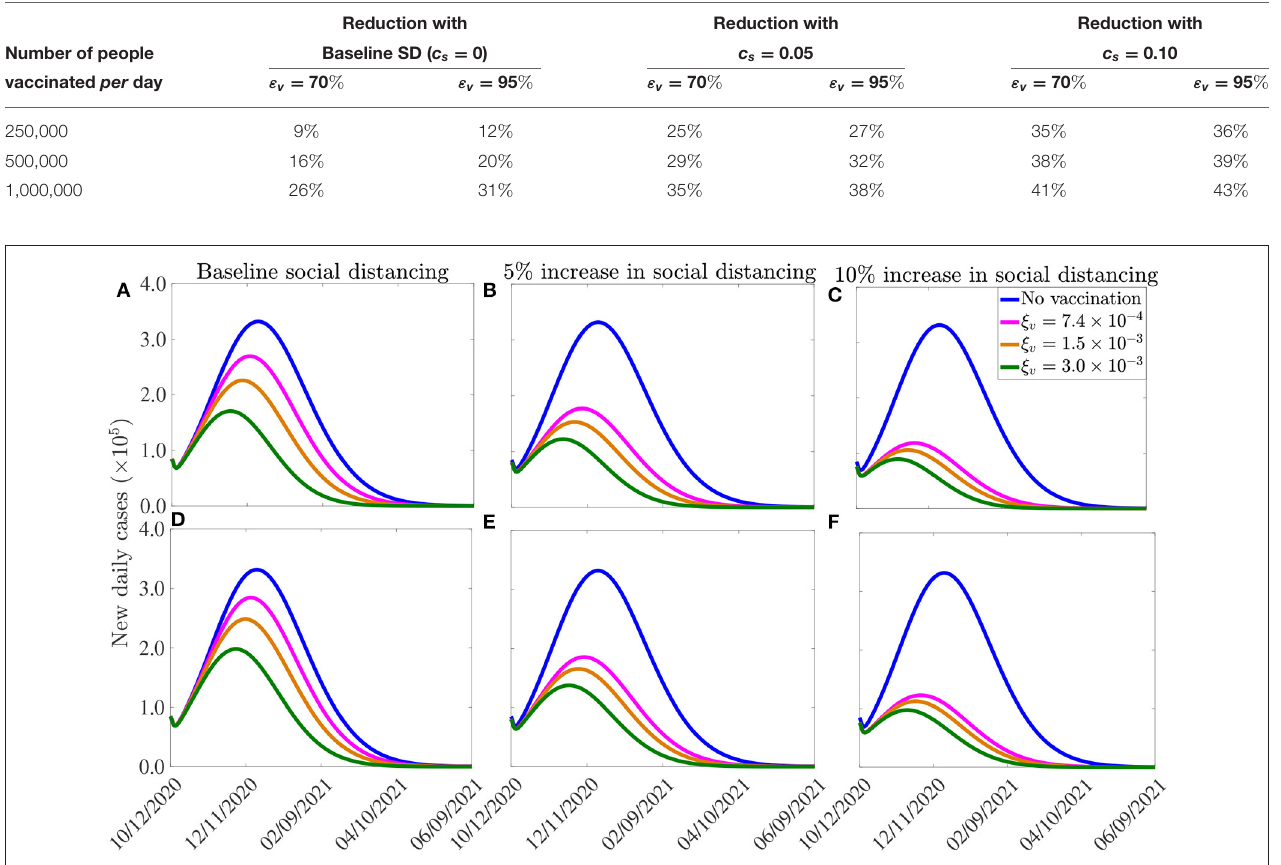
FIGURE 7 | Effect of vaccination and social-distancing on time-to-elimination. Simulations of the model (2.5)–(2.6), depicting the impact of three vaccines against COVID-19 (the AstraZeneca vaccine, and the Pfizer or Moderna vaccine) and social-distancing, on time-to-elimination of the pandemic in the U.S. (A–C) Moderna or Pfizer vaccines. (D–F) AstraZeneca vaccine. The social-distancing compliance is baseline for (A,D) , c s = 0.05 for (B,E) , and c s = 0.10 for (E,F) . The vaccination rates ξ v = 7.4 × 10 − 4 ,1.5 × 10 − 3 ,3.0 × 10 − 3 per day correspond, respectively, to vaccinating approximately 2.5 × 10 5 ,5.0 × 10 5 ,1.0 × 10 6 people per day. The values of the other parameters of the model used in the simulation are as given in Tables 3 , 4